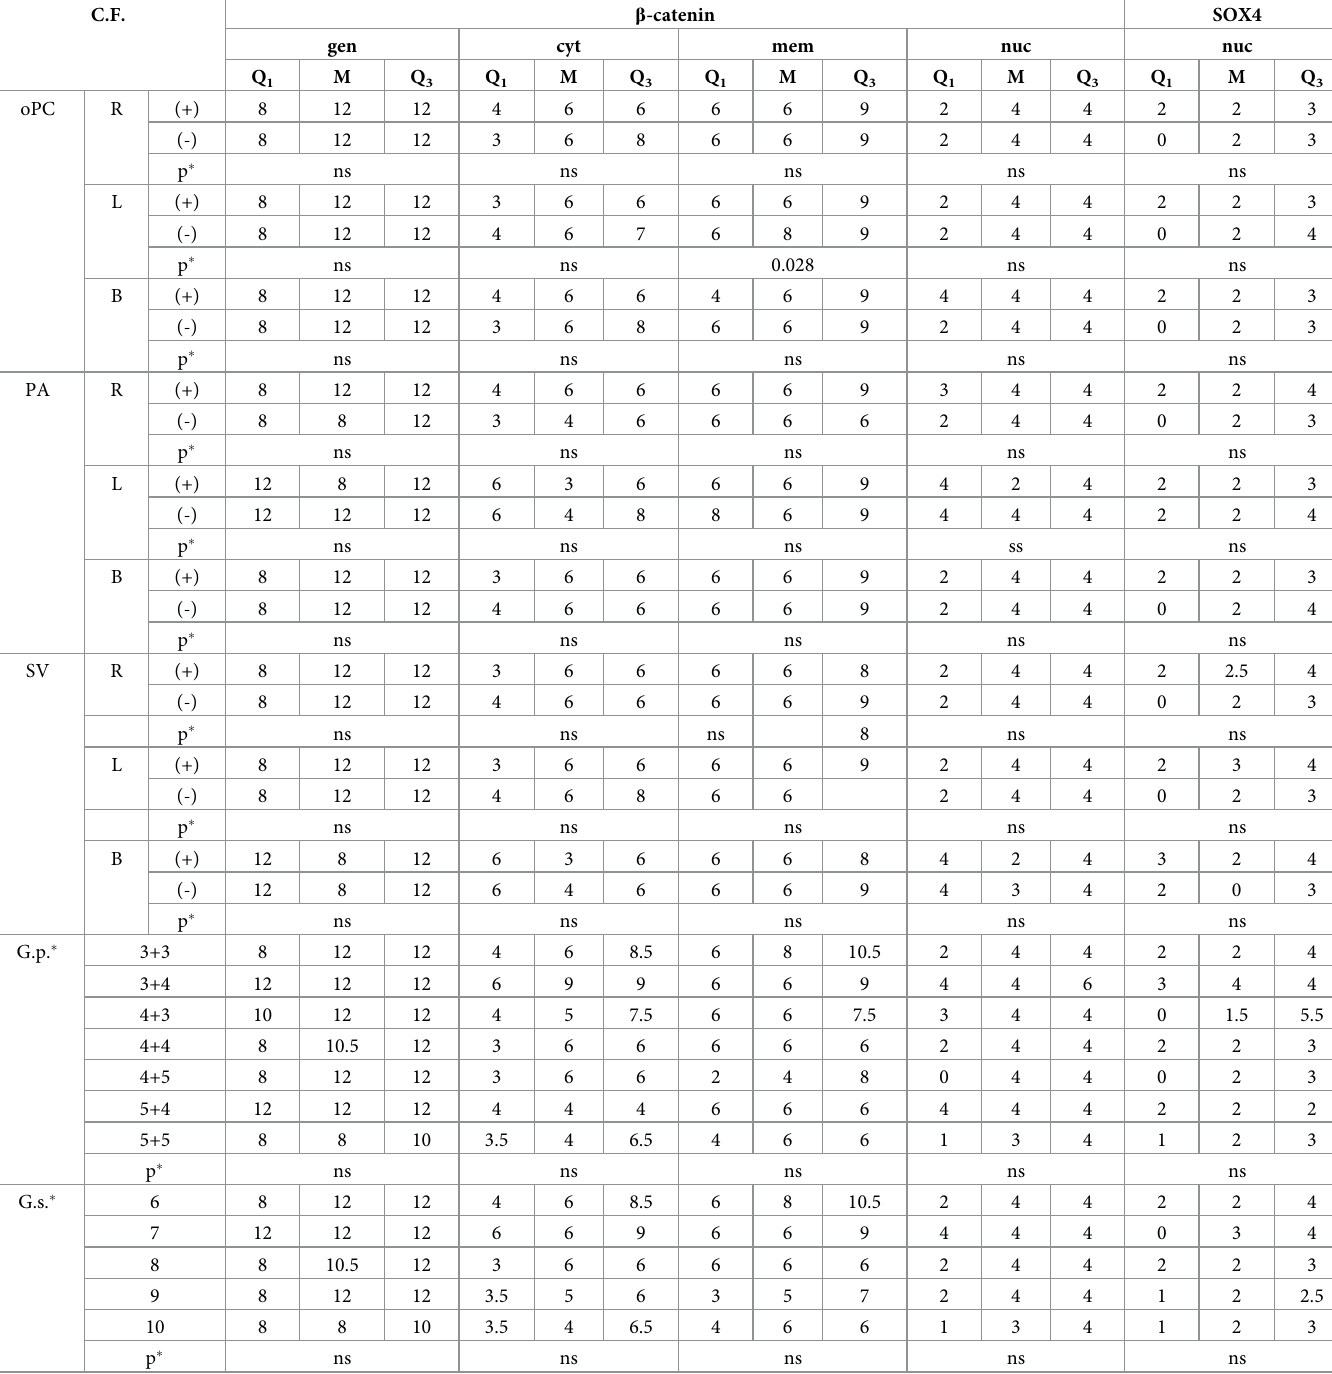
Table 5. Correlations between β -catenin, SOX-4 and invasion area and histological grading of tumor tissue which has grown through the prostate.